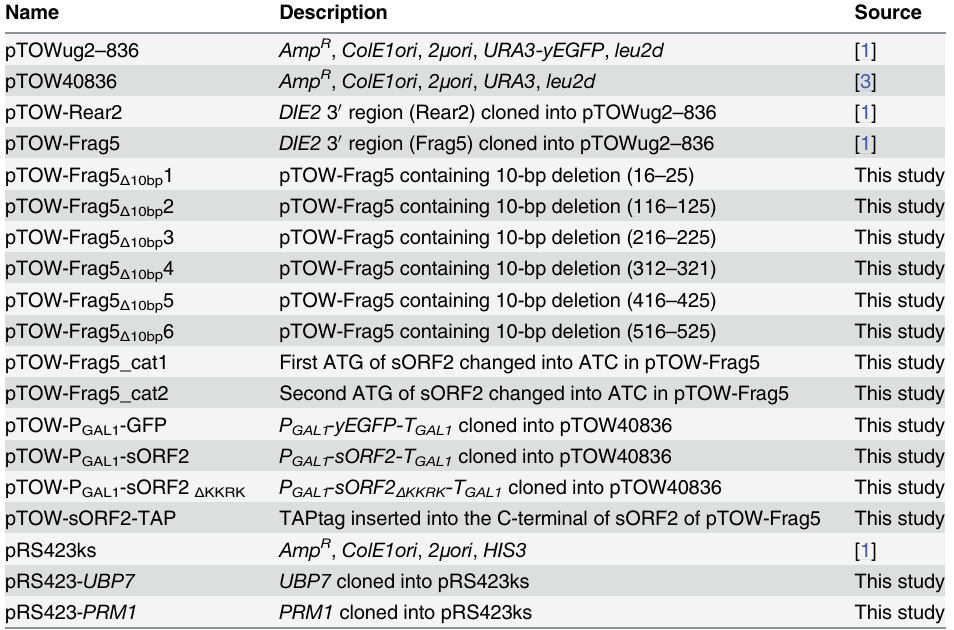
Table 3. Plasmids used in this